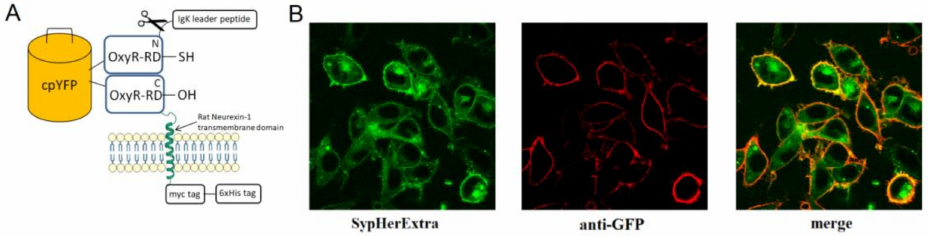
Figure 1. ( A ) Schematic representation of a genetically encoded construct SypHerExtra with ex- tracellular expression and membrane anchoring; ( B ) fluorescent images of the fixed HEK293 cells expressing extracellular membrane-anchored SypHerExtra sensor ( left ) stained with anti-GFP anti- bodies ( center ). The merged image ( right ) indicates membrane-anchored